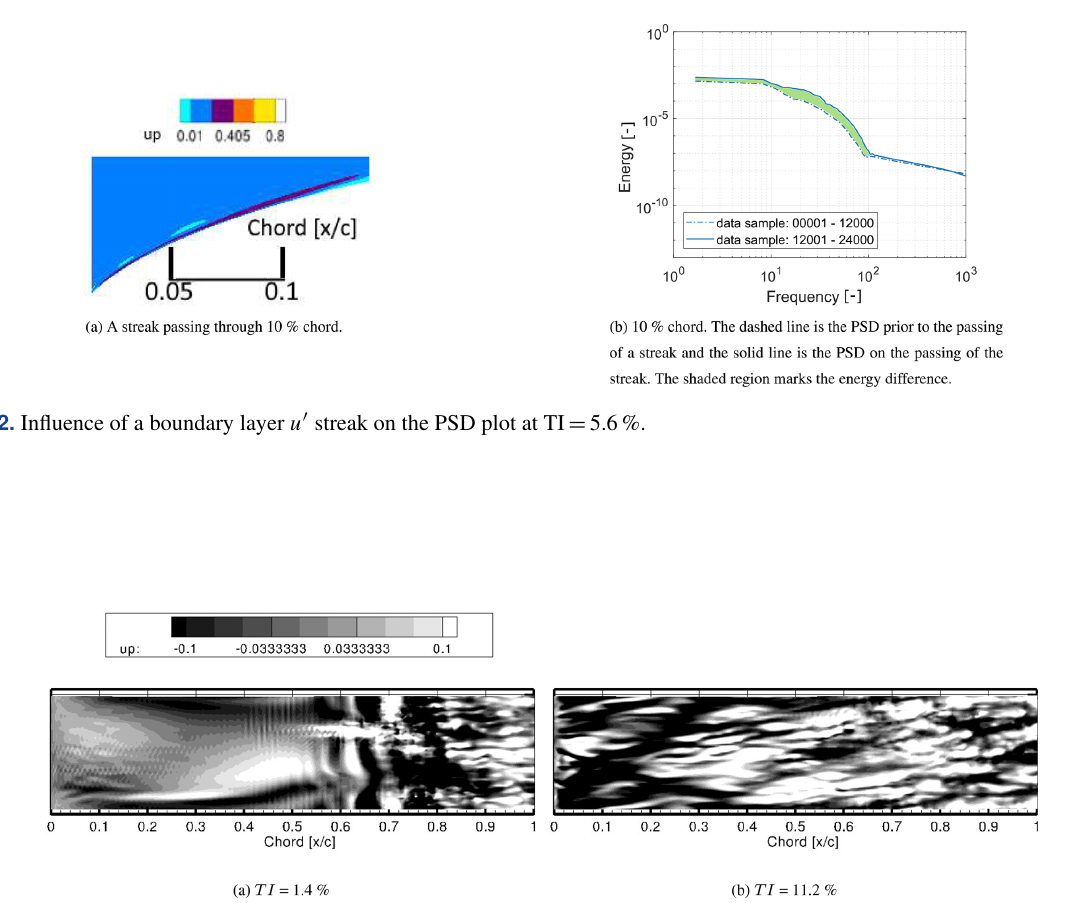
Figure 13. u (cid:48) boundary layer streaks. Slices are taken at a wall-normal height equal to the displacement thickness at 20% chord.